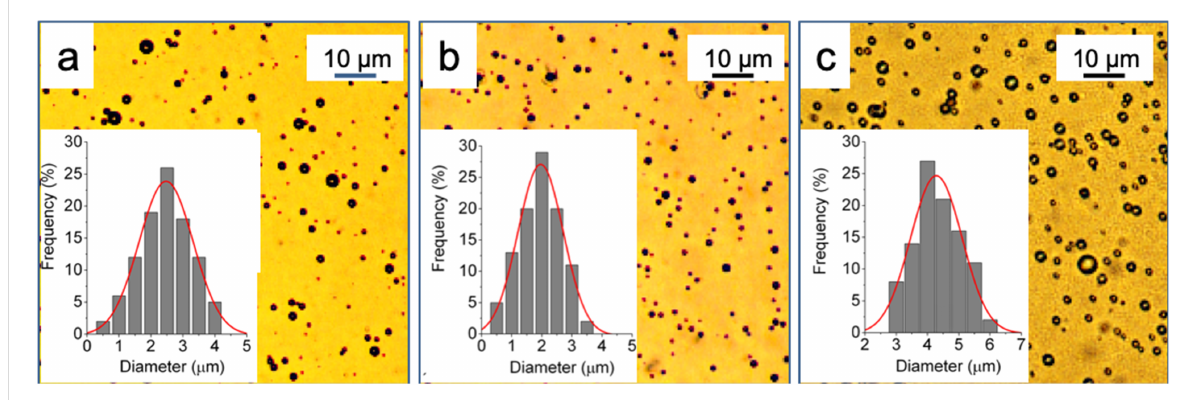
Figure 3: Optical micrographs and corresponding size distribution of the perfluorohexane-stabilized microbubbles with a shell of a) DPPC, b) DPPC/ F -lipopeptide 3 , and c) DPPC/hydrocarbon analog 4 .